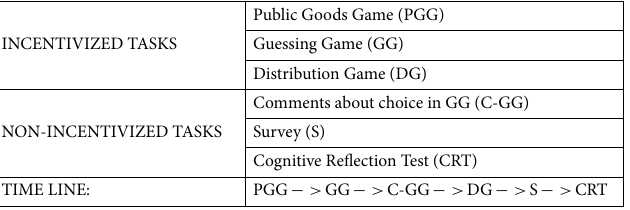
Table 1. Sequence of tasks in each session. PGG sessions included two variants of the Public Good Game: Standard and Strategy Method. The Results concerning these games are discussed in 57